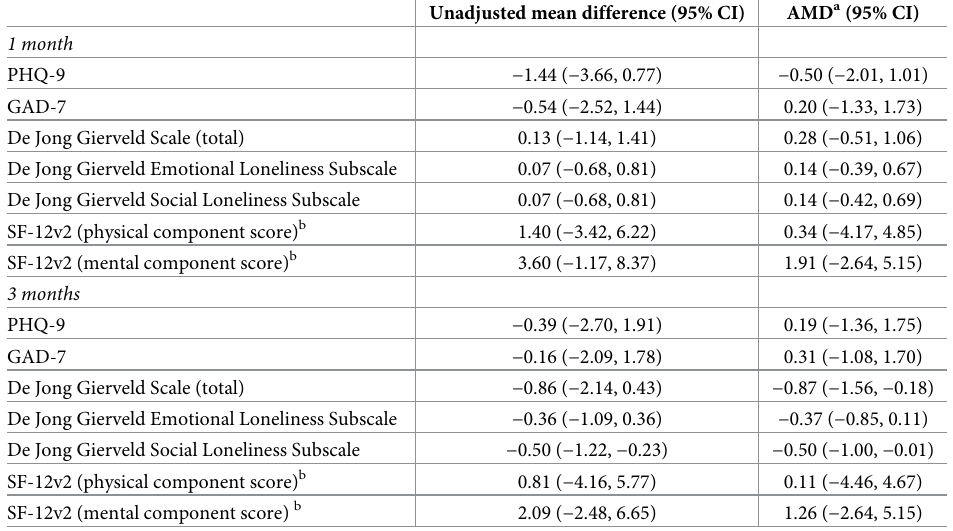
Table 3. Unadjusted and AMD between groups at 1 and 3 months for primary and secondary outcomes measure. Unadjusted mean difference (95%